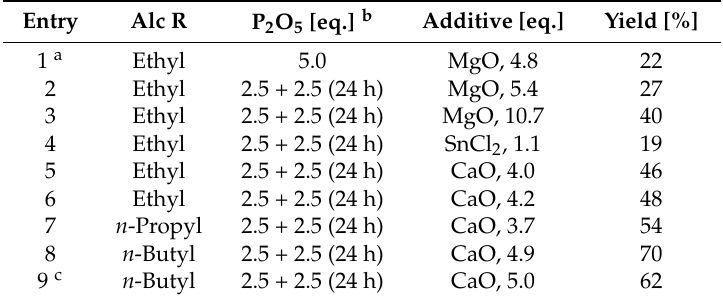
Table 3. Reaction conditions for the cyclisation of 5-alkoxy-4-methyl-oxazoles.